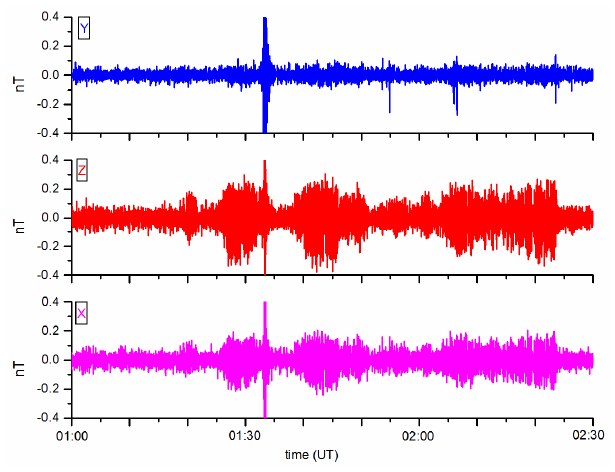
Fig. 6. Residual field depurated from inductive and external fields. Fig. 6 Residual field depurated from inductive and external fields